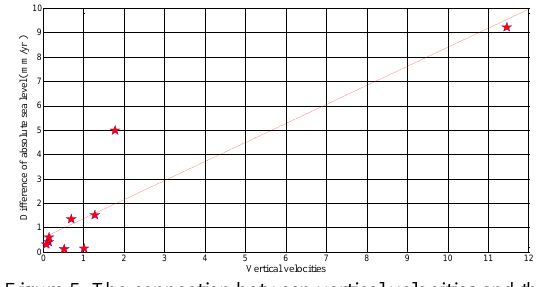
Figure 5. The connection between vertical velocities and the difference of the absolute sea level from GNSS+TG and